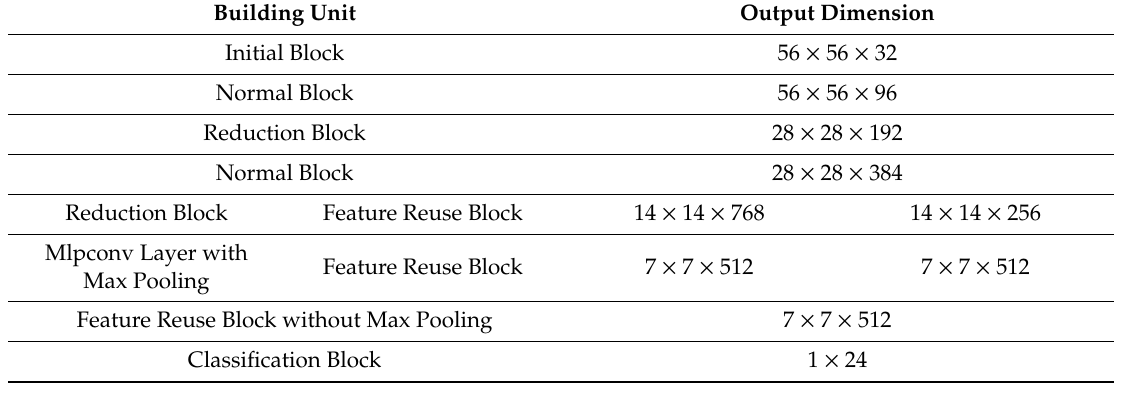
Table 3. Structure of BridgeNet-19. The input size is 224 × 224 × 3. The initial block followed the setting of ResNet-50. Table 4. Hyper-parameters for training models.